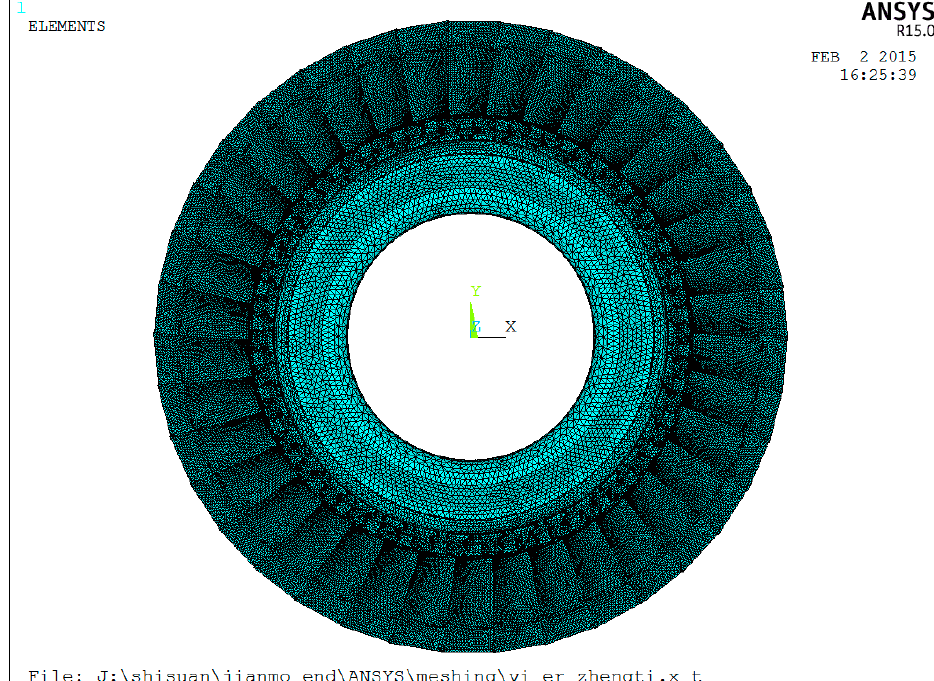
Figure 9. Finite element model of the first-stage bladed disk.